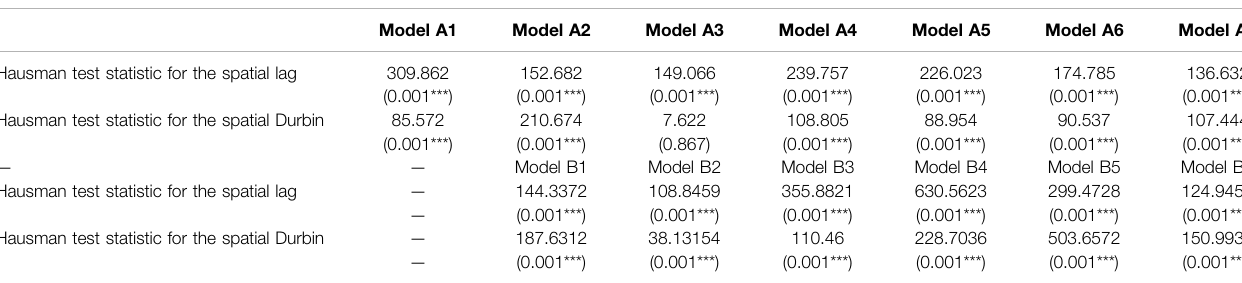
TABLE 6 | Hausman test